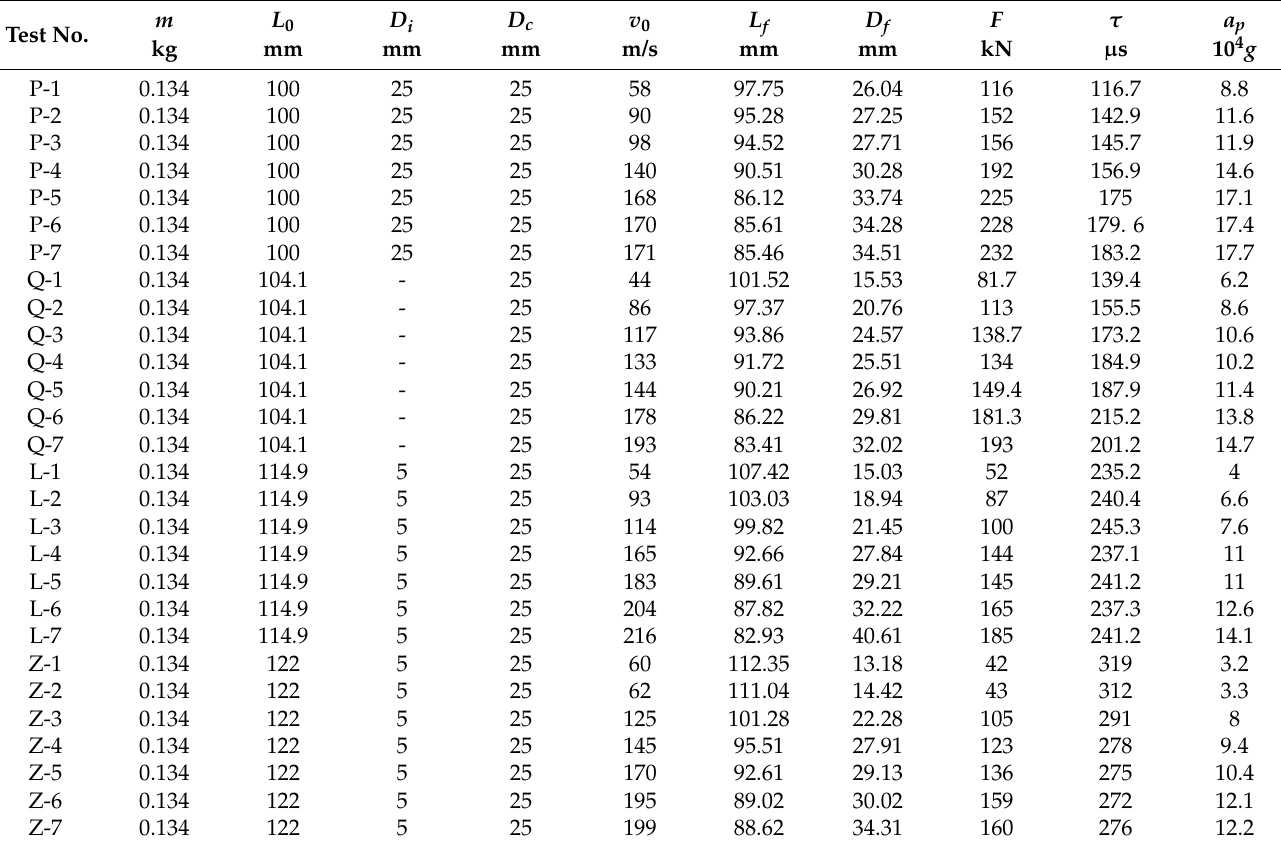
Table 3. Experiments information and